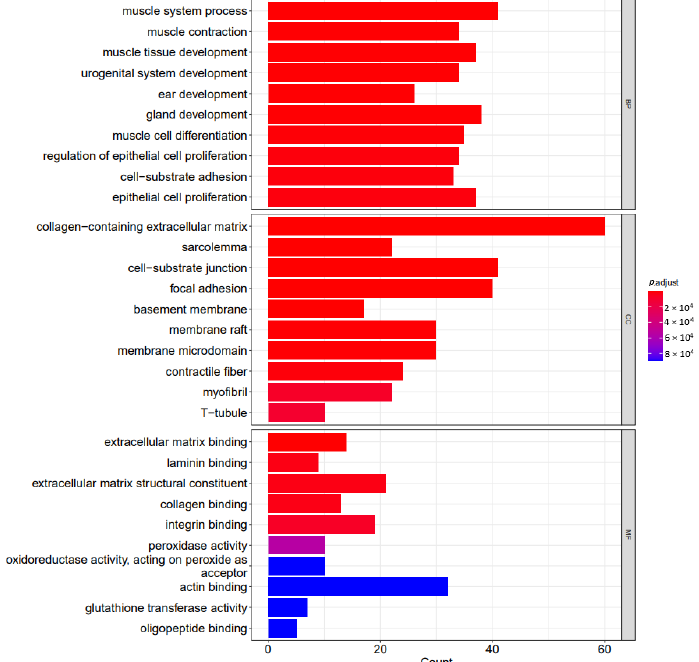
Figure 7. The bar plots of the top 10 enriched functions include BP (biological process), CC (cellular component), and MF (molecular function). The gene-set count is shown on the X axis, while the gene-set function is shown on the Y axis; the bar color, which ranges from red (most significant) to blue (least significant), indicates the adjusted p value. Cells 2022 , 11 , x FOR PEER REVIEW The dot plot of the top 10 enriched functions and the enriched GO-induced graph are, respectively, visualized in Figures 8 and 9.